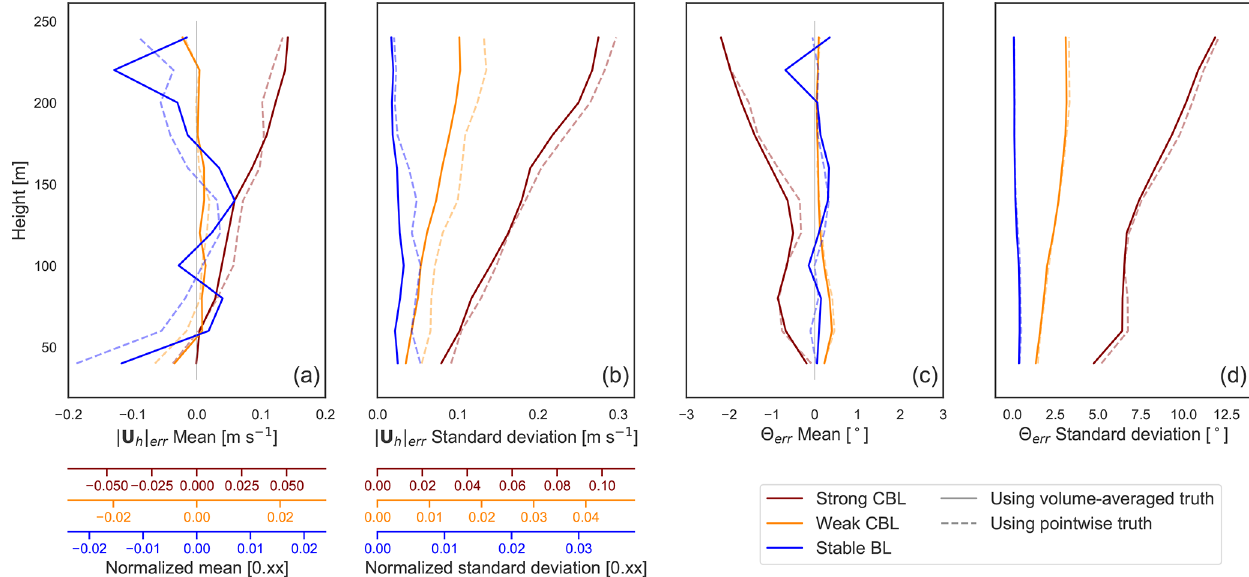
Figure 14. Mean and standard deviation of error in (vector) 10min averaged wind speed and wind direction. For wind speed, the primary axis gives absolute error, and colored secondary axes designate relative error with respect to 100m values for the respective LES case.